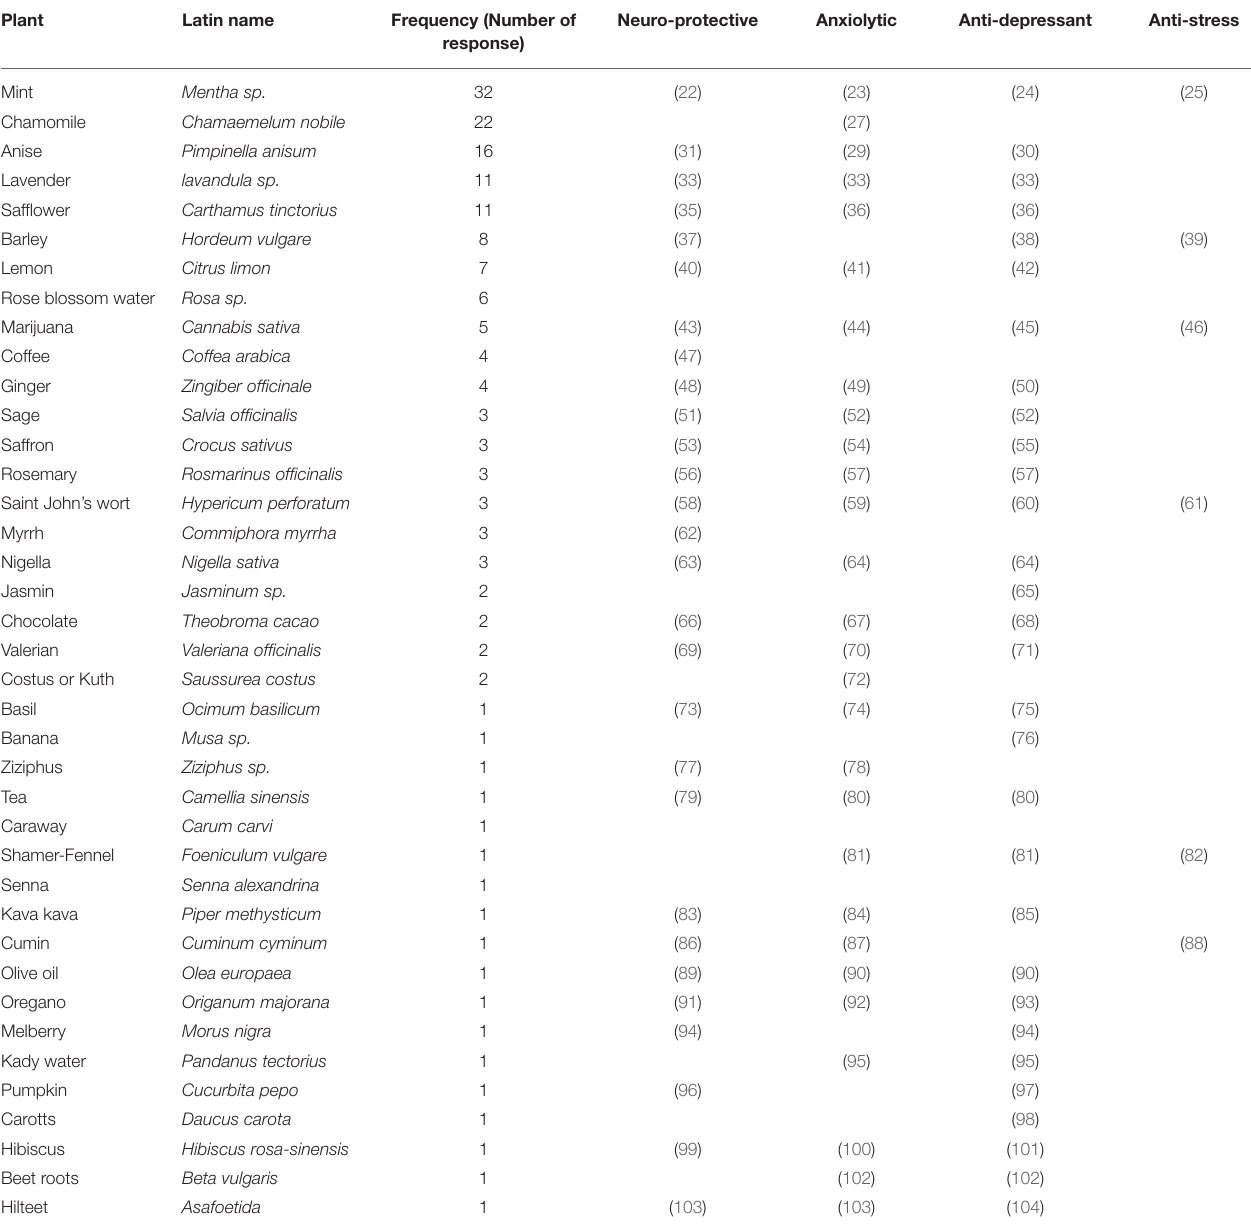
TABLE 8 | Participants suggestions about plants and herbs used traditionally for psychotherapy.